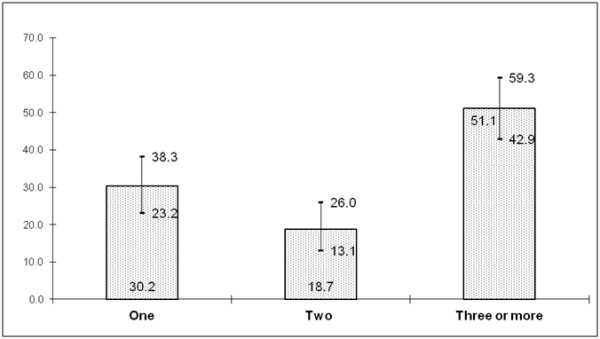
Number of partners of MSM in last 12 months (with 95% CI).